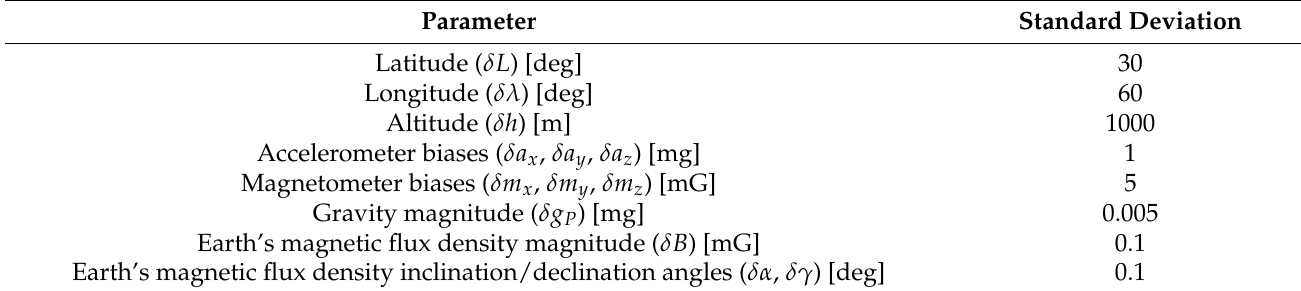
Table 3. Standard deviations of Monte Carlo simulated test main input